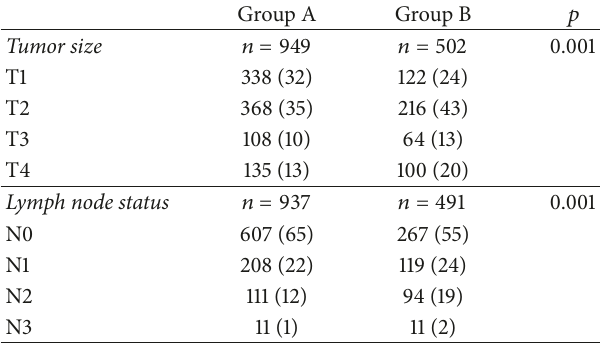
Table 1: Tumor size and lymph node status in 1,607 patients with oral squamous cell carcinoma, compared by frequency of dental visits.